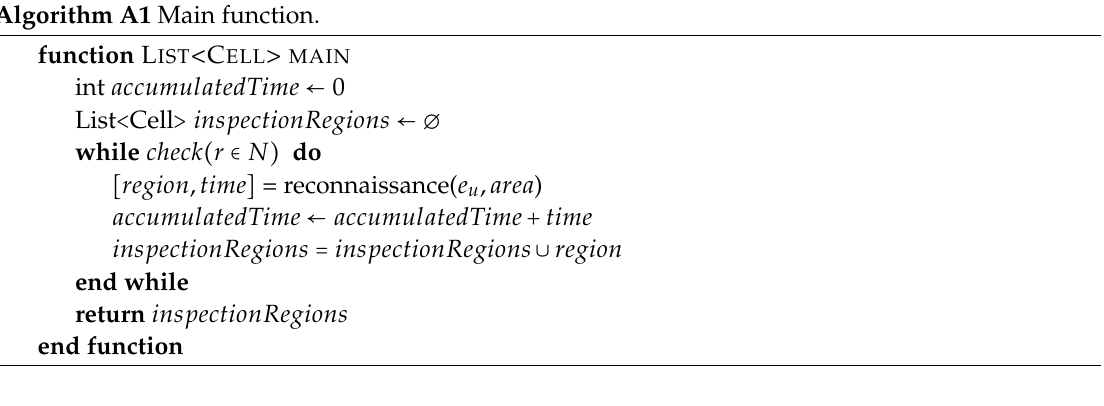
Algorithm A2 Reconnaissance